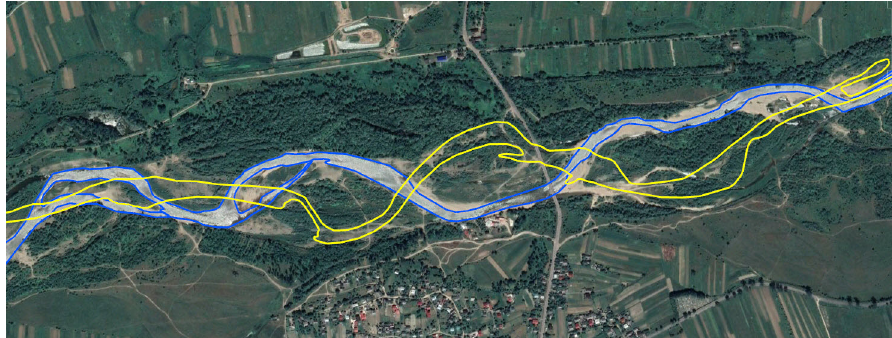
Figure 5. Dynamic of Limnitsa riverbed’s changing on the basis of space images